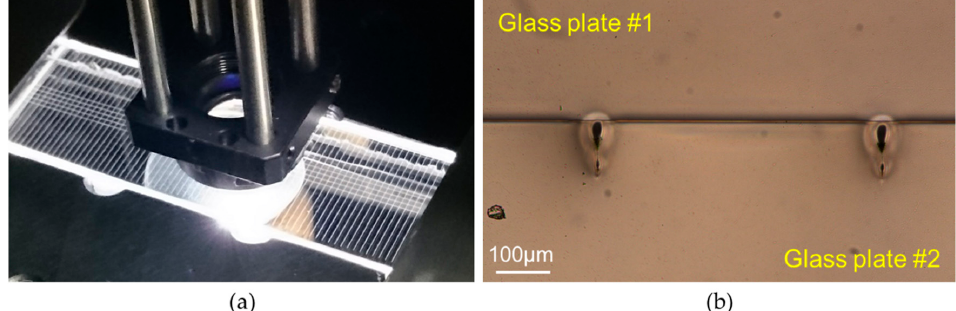
Figure 7. ( a ) Photograph taken during the laser welding of two 1.1-mm-thick glass plates; ( b ) cross- section of the weld seams generated at P = 2 W and v = 2 mm/s.